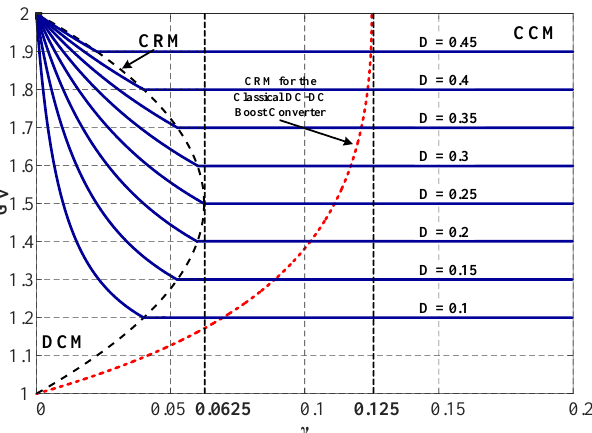
Figure 3. Comparison between static gain curves of the conventional and 3SSC-A-based boost converters.